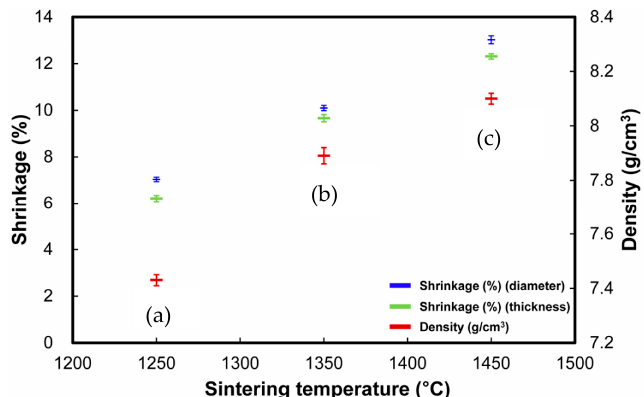
Figure 3. Percent of shrinkage and density of the Co–Cr alloys at three different post-sintering temperatures : ( a ) 1250 °C; ( b ) 1350 °C; ( c ) 1450 °C.